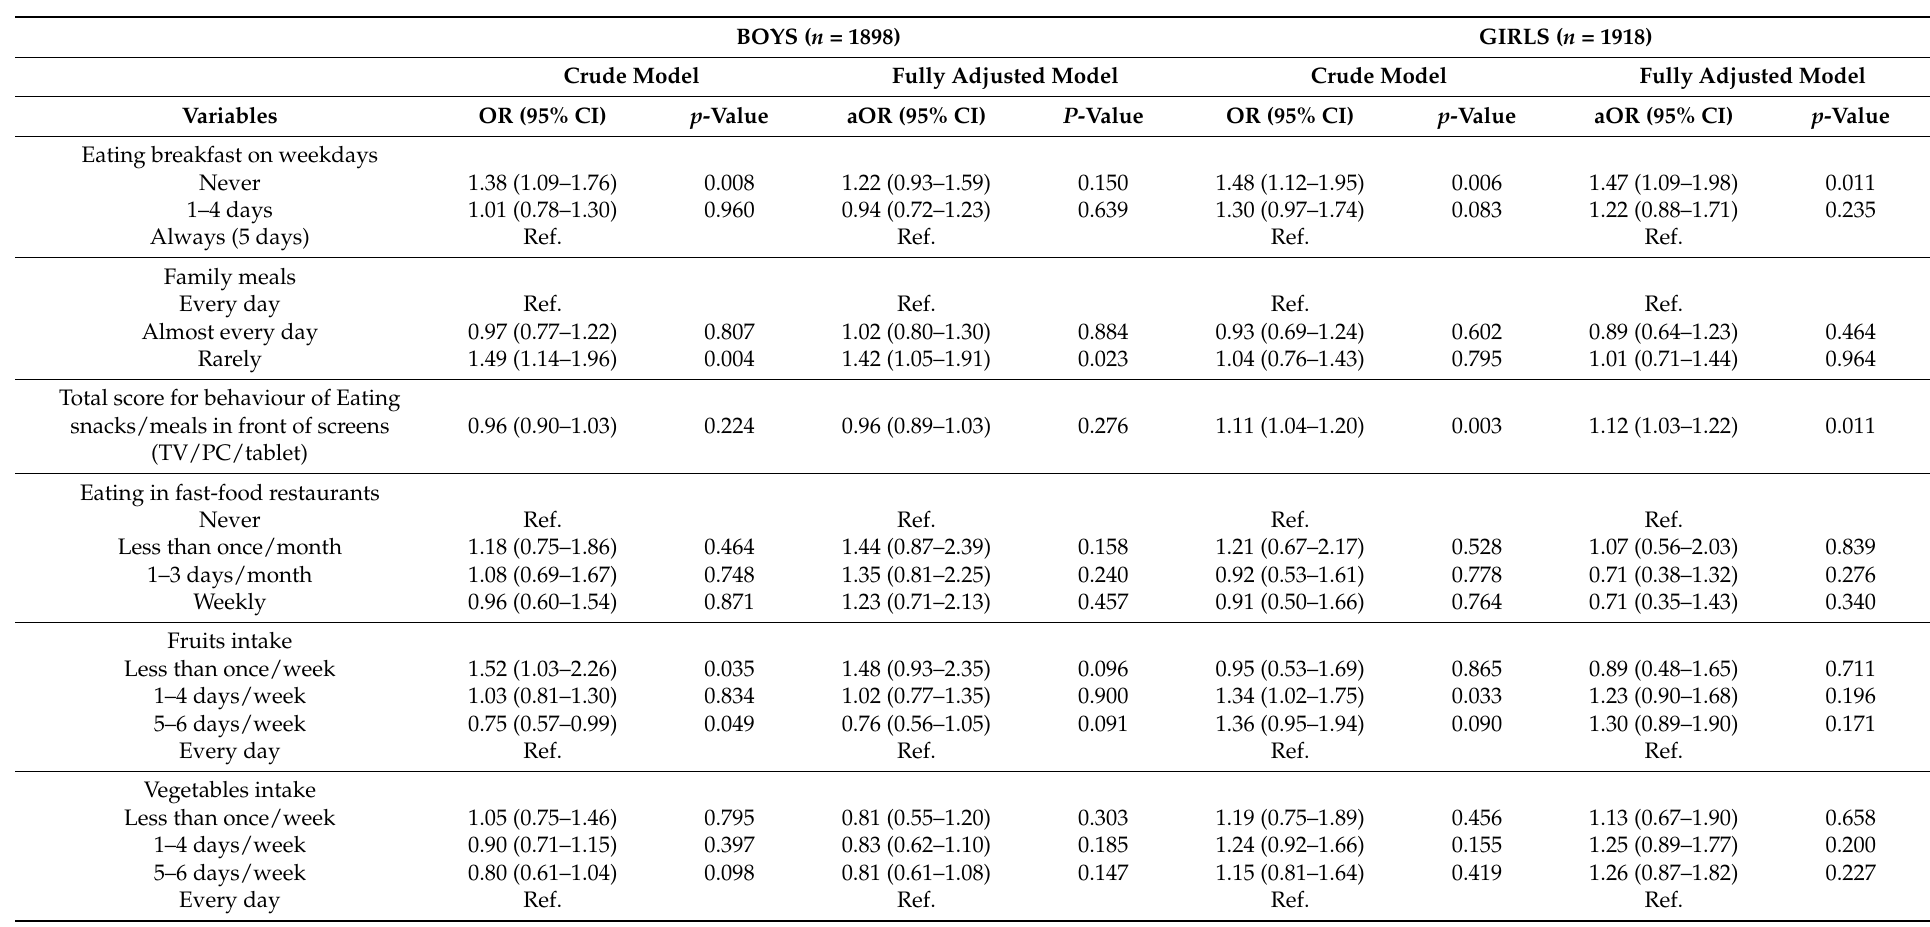
Table 4. Crude and adjusted odds ratios (aOR) and associated 95% confidence intervals (CI) from logistic regression models exploring the association of overweight with diet-related behaviours and habits among 1898 school-aged boys and 1918 school-aged girls participants in the 2018 Greek arm of the HBSC study